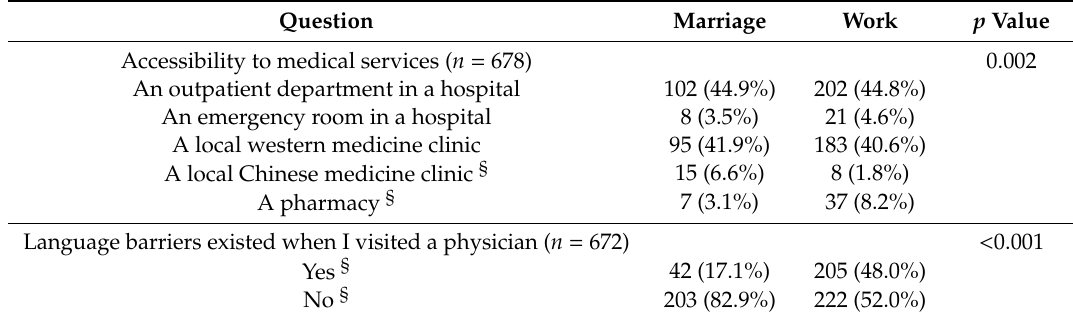
Table 3. Single-response questions associated with access of the study population to healthcare, stratified by reasons for migrating to